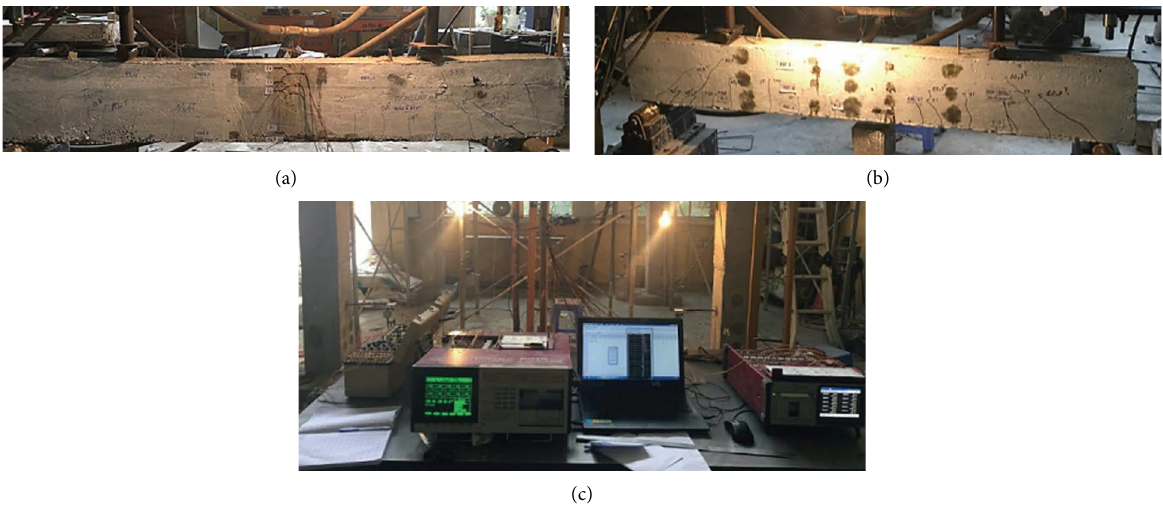
Figure 4: Test pedestal with measuring equipment and concrete beams: (a) measurement instruments for beams; (b) beams made of concrete were placed on the test pedestal; (c) connection of the measuring devices to the